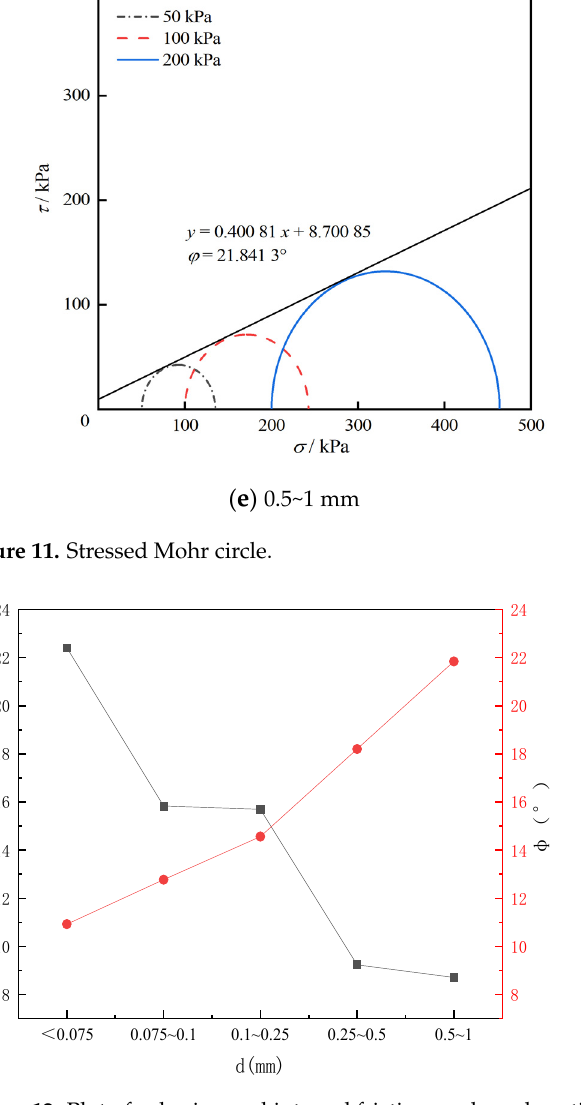
Figure 12. Plot of cohesion and internal friction angle and particle size.